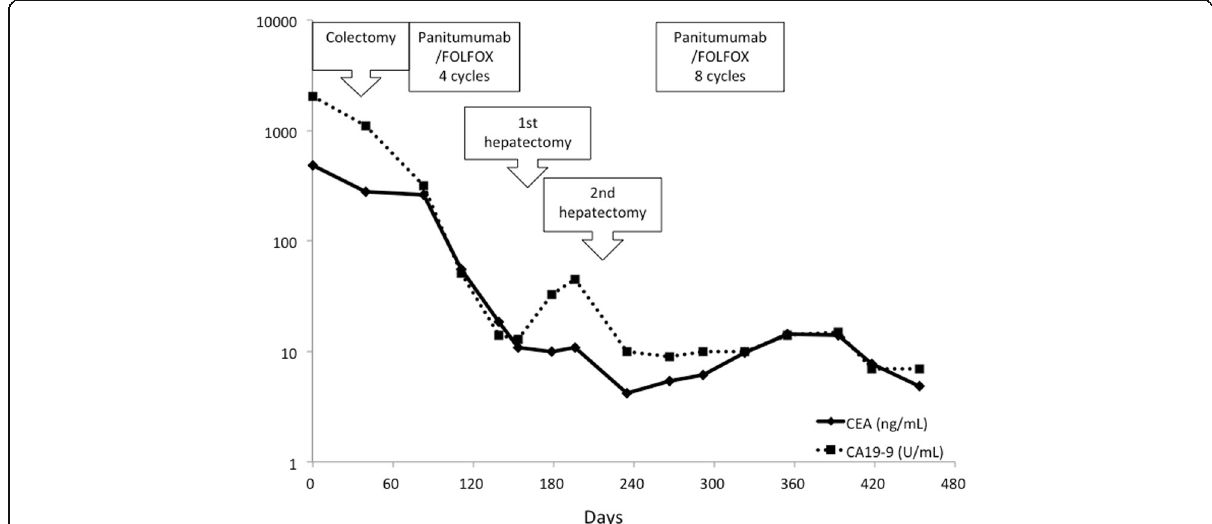
Fig. 4 Trends in the tumor markers over the patient ’ s treatment course. FOLFOX 5-fluorouracil, leucovorin, and oxaliplatin, CEA serum carcinoembryonic antigen, CA19-9 serum carbohydrate antigen